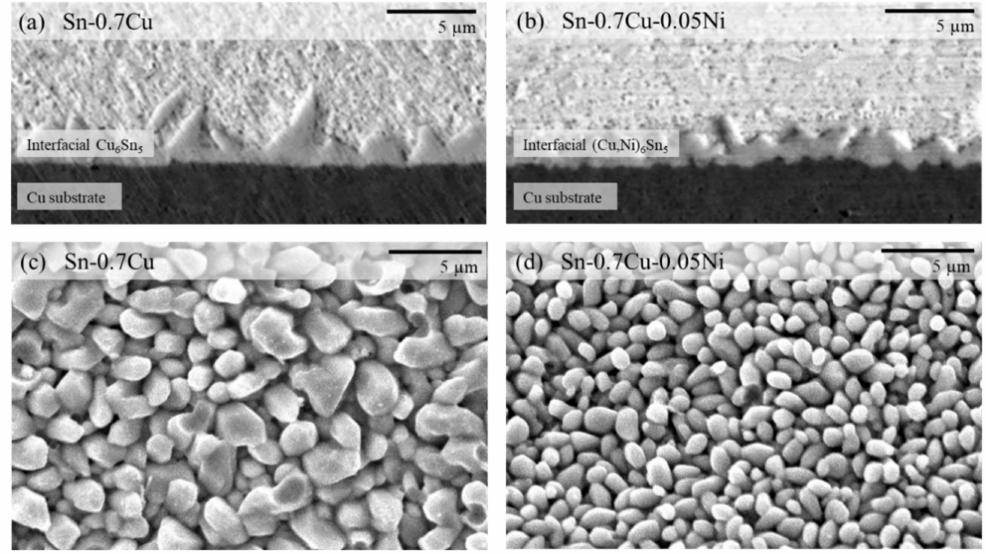
Figure 9. The morphology of the intermetallic compound (IMC) interfacial layer of Sn-0.7Cu and Sn-0.7Cu-0.05Ni solder joints. ( a ) Cross-section view of the interfacial Cu 6 Sn 5 , ( b ) cross-section view of the interfacial (Cu,Ni) 6 Sn 5 , ( c ) top view of the interfacial Cu 6 Sn 5 and ( d ) top view of the interfacial (Cu,Ni) 6 Sn 5